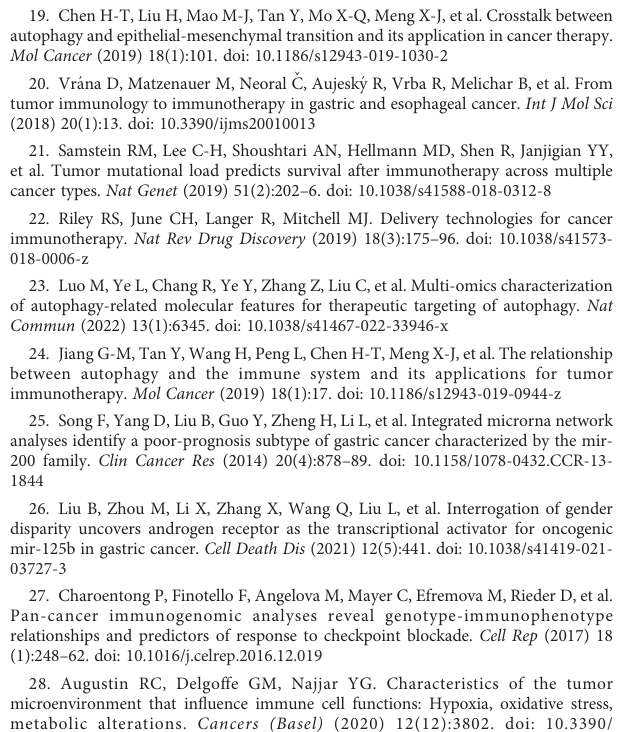
SUPPLEMENTARY TABLE 1 The baseline information of the patients. SUPPLEMENTARY TABLE 2 The results of Subgroup and risk score of GC samples. SUPPLEMENTARY TABLE 3 The OR of deferentially mutating genes in patients of the low- and the high- risk groups. SUPPLEMENTARY TABLE 4 The expression correlation of target protein-coding genes and prognostic genes, assessed using Pearson correlation analysis. SUPPLEMENTARY TEXT Including materials and methods, Figures S1,